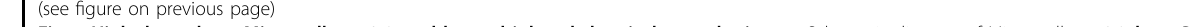
Fig. 1 High-throughput Microwell-seq 2.0 enables multiplexed chemical perturbations. a Schematic diagram of Microwell-seq 2.0. b , c qPCR and NGS analysis using three lysis buffers, respectively: Microwell-seq 1.0 lysis buffer, 2.0 lysis buffer (with 20% and 50% Formamide). Data are means ± SD, n = 4; P values were calculated by Student ’ s t -test; ns, no signi fi cance; ** P < 0.01, *** P < 0.001 ( b ). Scatter plot of NGS data shows the transcript number versus the read number of each individual cell ( c ). A summary of NGS was listed in Supplementary Table S6. d Scatter plot of human – mouse mix test using Microwell-seq 2.0. Only 0.69% (purple dots) are human – mouse mixed cells. e t-SNE map of adult mouse testis analyzed by Microwell- seq 2.0. Cells are colored by cell-type cluster. SPG, spermatogonia; SPC-L/Z, spermatocyte-leptotene/zygotene; SPC-Pach, spermatocyte-pachytene; SPC-MD, spermatocyte-meiotic division; SPC-Acr, spermatocyte-acrosomal phase; rSpd, round spermatid; eSpd, elongating spermatid. f − h PAGA graphs show the potential cell transitions in chemical perturbation. Five cell-type clusters were labeled in the graph generated by ForceAtlas2 (FA2) ( f ). Forty-eight small-molecule combinations were labeled in the graph generated by FA2 ( g ). PAGA plots show cell distribution after treatment with different small-molecule combinations ( h ). i PAGA graph shows the potential cell transitions in perturbation of CHIR-99021 (CH), PD173074 (P1), PD0325901 (P0), and Retinoic acid (RA). j A gene expression heatmap shows top differentially expressed genes for small-molecule combinations in i . Yellow corresponds to high-expression levels; purple and black correspond to low-expression